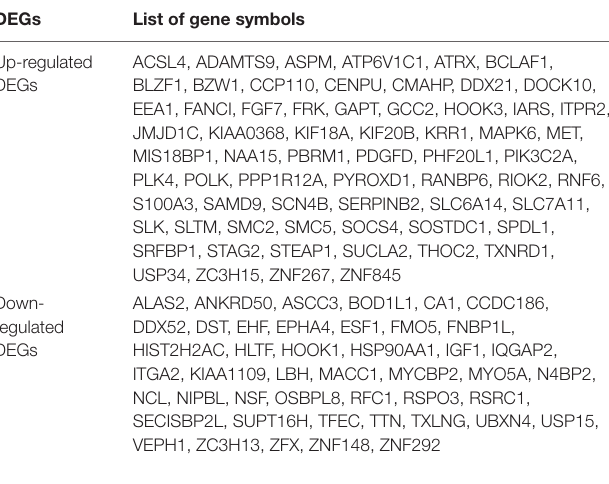
TABLE 2 | Screening of differentially expressed genes (DEGs) in pulmonary arterial